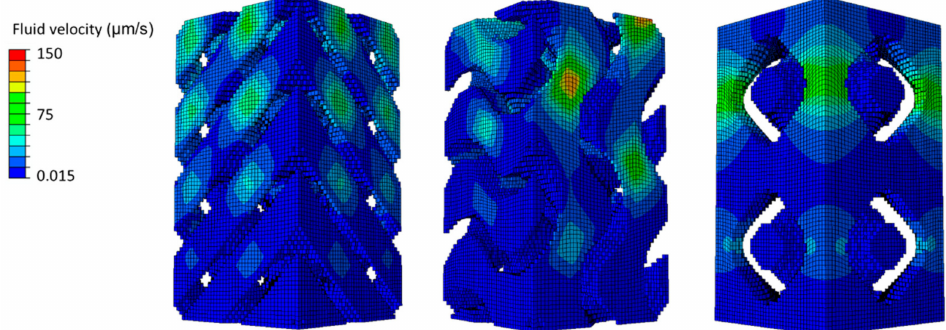
Figure 5. Fluid flow velocity distribution at peak compression over the collagen substrate in contact with TPMS sca ff olds (left: SD70; center: SG70; right: SP70). Please note that the sca ff old has been removed for the sake of visualization.